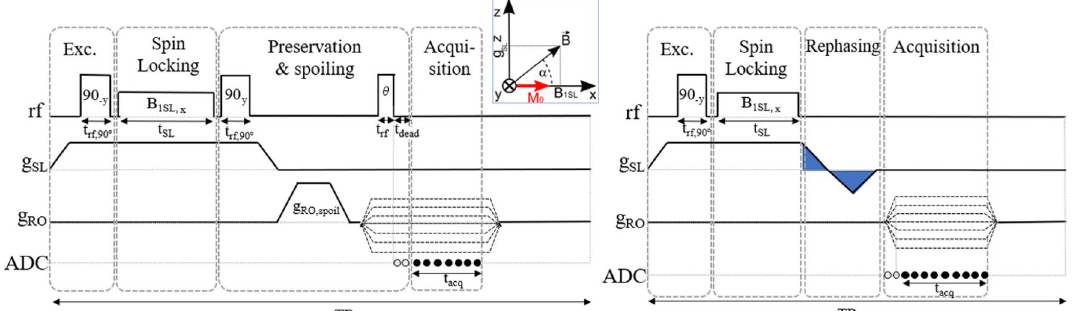
Figure 1. Proposed protocols for 2D imaging of short T 2 samples: PreSLoP (left) and DiSLoP (right). The empty circles in the ADC (analog-to-digital converter) line indicate the dead time, before the start of the acquisition, which leads to the gap at the k-space center. The inset shows the rotating frame field